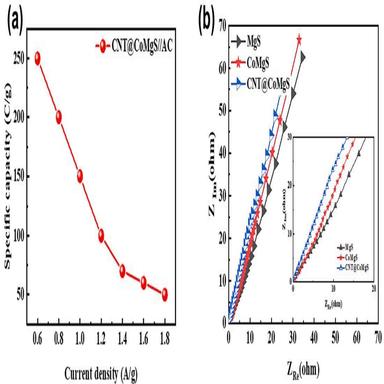
(a) Specific capacity (Qs) of CNT@CoMgS//AC. (b) Electrochemical impedance spectroscopy (EIS) of MgS, CoMgS and CNT@CoMgS. Inset Figure shows the EIS measurement at small-scale.